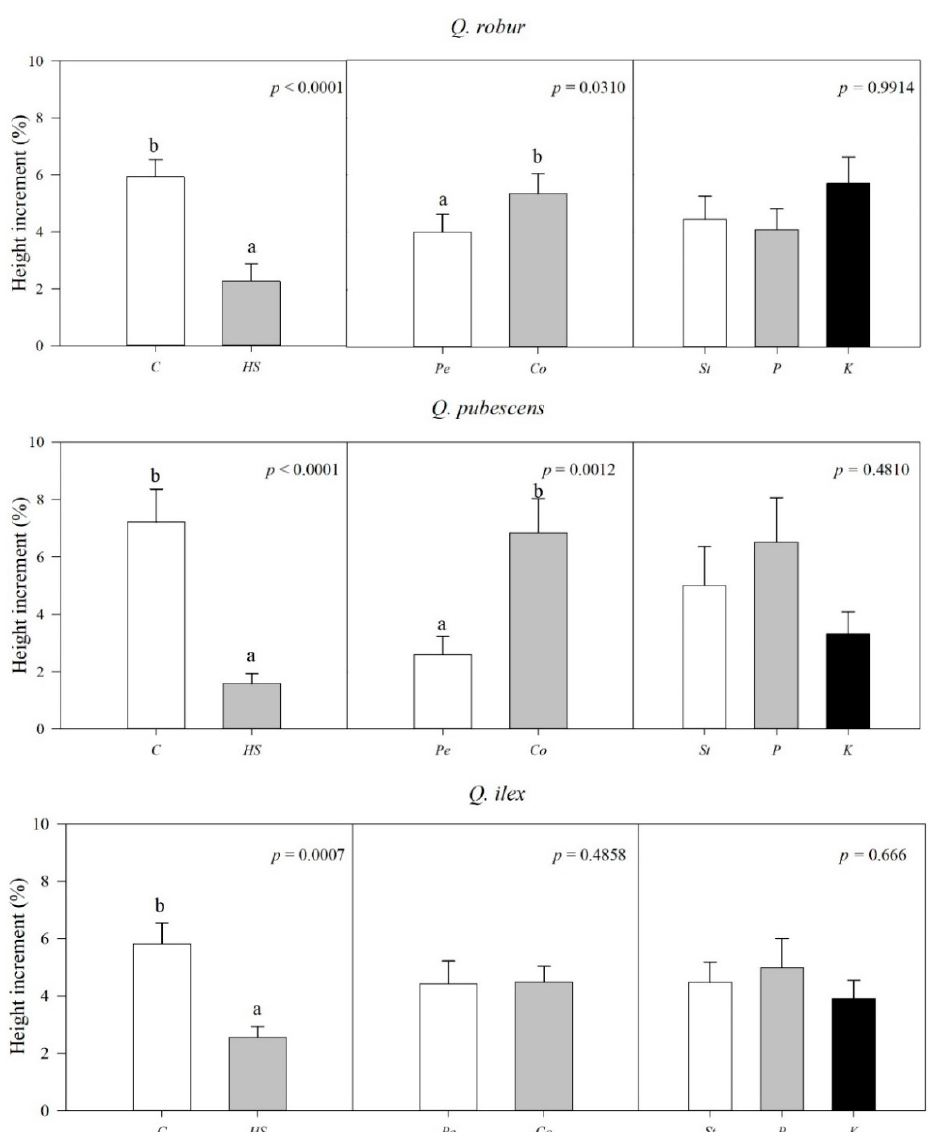
Figure 1. Mean values (and SE) of seedlings’ percent height increment (I%) at T 1 as affected by water stress ( left ), substrate ( center ), and fertilization ( right ). P values from multifactorial ANOVA are shown on top of each sub-figure. Lowercase letters indicate homogeneous groups ( p ≤ 0.05 ). C, HS : control and high water stress; Pe , Co : peat and coir substrate; St, P, K : standard, P- and K-enriched fertilization. Table 3. Multifactorial ANOVA test results for seedlings height (cm) at T 0 (before the onset of water stress). Lowercase letters indicate homogeneous groups ( p ≤ 0.05). Pe , Co : peat and coir substrate; St, P, K : standard, P-and K-enriched fertilization. In bold significant results.